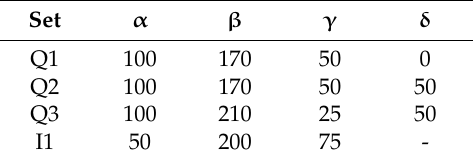
Table 2. Values (in µ m) of geometrical parameters for the compensation structures.